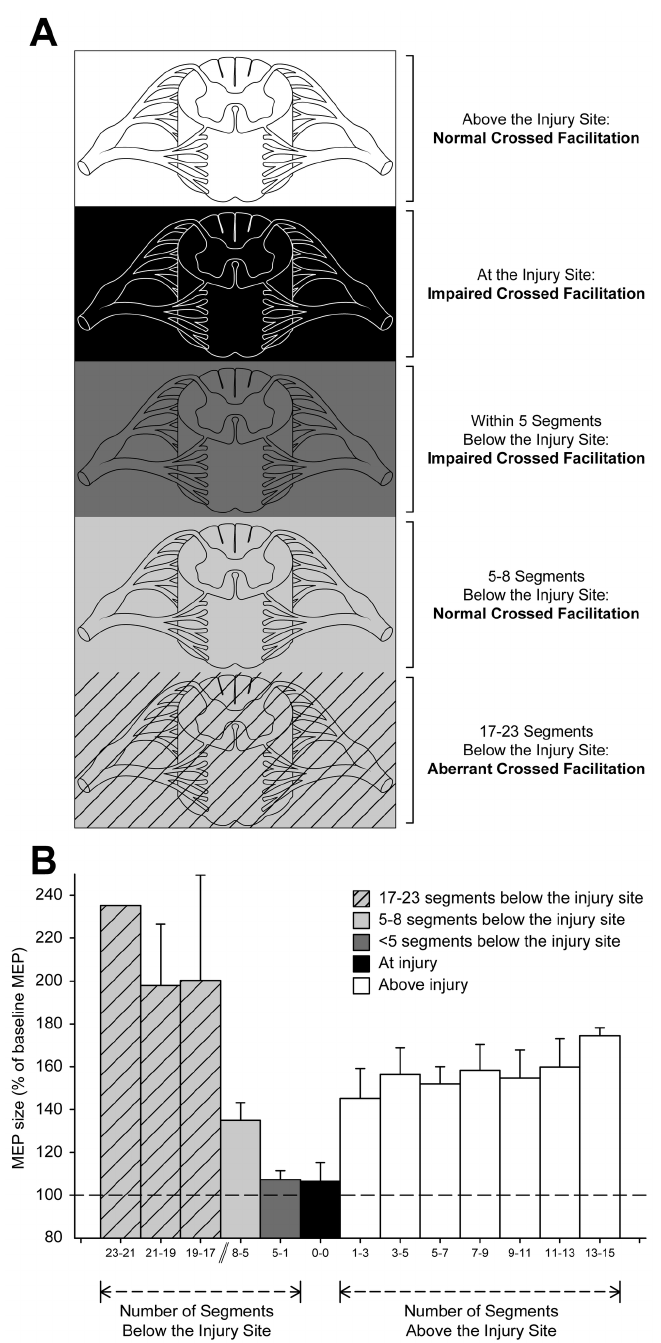
Figure 5. Segmental level of injury and MEPs. Schematics of the spinal cord illustrating segments above the injury (white area), at the injury site (black shaded area), within 5 segment below the injury (dark gray shaded area) and greater than 5 segments below the injury site (5-8 segments light shaded area; 17-23 segments light gray-striped area). (B) MEPs recorded from the BB, FDI, and TA in all motor tasks and patients tested are plotted as a function of the segmental level of injury. The abscissa shows the number of segments (grouped by 3 segments) from all muscles tested. The ordinate shows the size of MEPs as a % of the baseline MEPs in all muscles. Note that when the muscle tested was at or within 5 segments below the injury the size of MEPs remained unchanged during 70% of MVC compared to rest. Whereas, when the muscle tested was more than 5 segments below the injury the size of MEPs was increased and aberrantly high at longer distances during 70% of MVC compared to rest. Error bars indicate SEs. doi: 10.1371/journal.pone.0076747.g005 PLOS ONE |